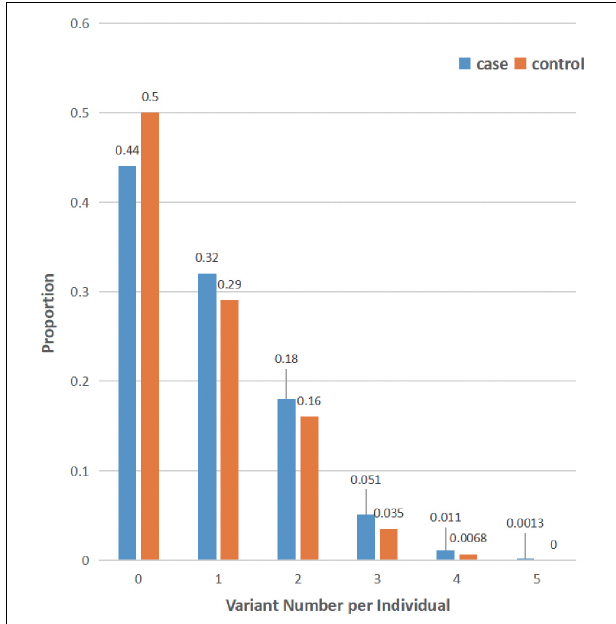
FIGURE 1 | Distribution of lysosomal storage disorder (LSD) variants in all subjects. The number of rare damaging LSD variants (MAF < 1%, ReVe score > 0.7) in each individual is shown as the proportion of cases (blue) or controls (orange). Many subjects harbor multiple LSD variants, and all variants of 69 LSD genes were